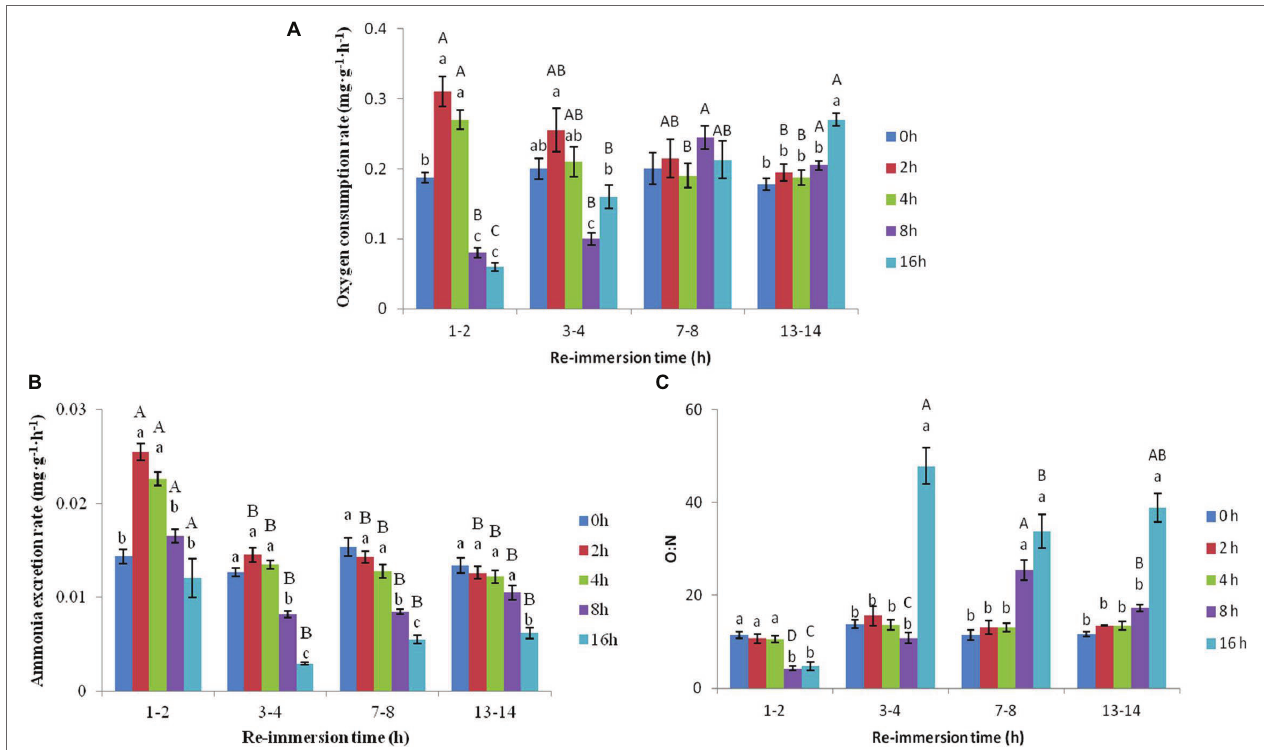
FIGURE 1 | Effects of air exposure and reimmersion on oxygen consumption rate (OCR; A ), ammonia excretion rate (AER; B ), and oxygen to nitrogen ratio (O:N; C ) in Chinese mitten crab. There was no significant difference between bars with the same letter ( p < 0.05). Different lowercase letters represent a significant difference between the different air exposure times at the same reimmersion time ( p < 0.05). Different uppercase letters represent a significant difference between the different reimmersion times at the same air exposure time ( p <